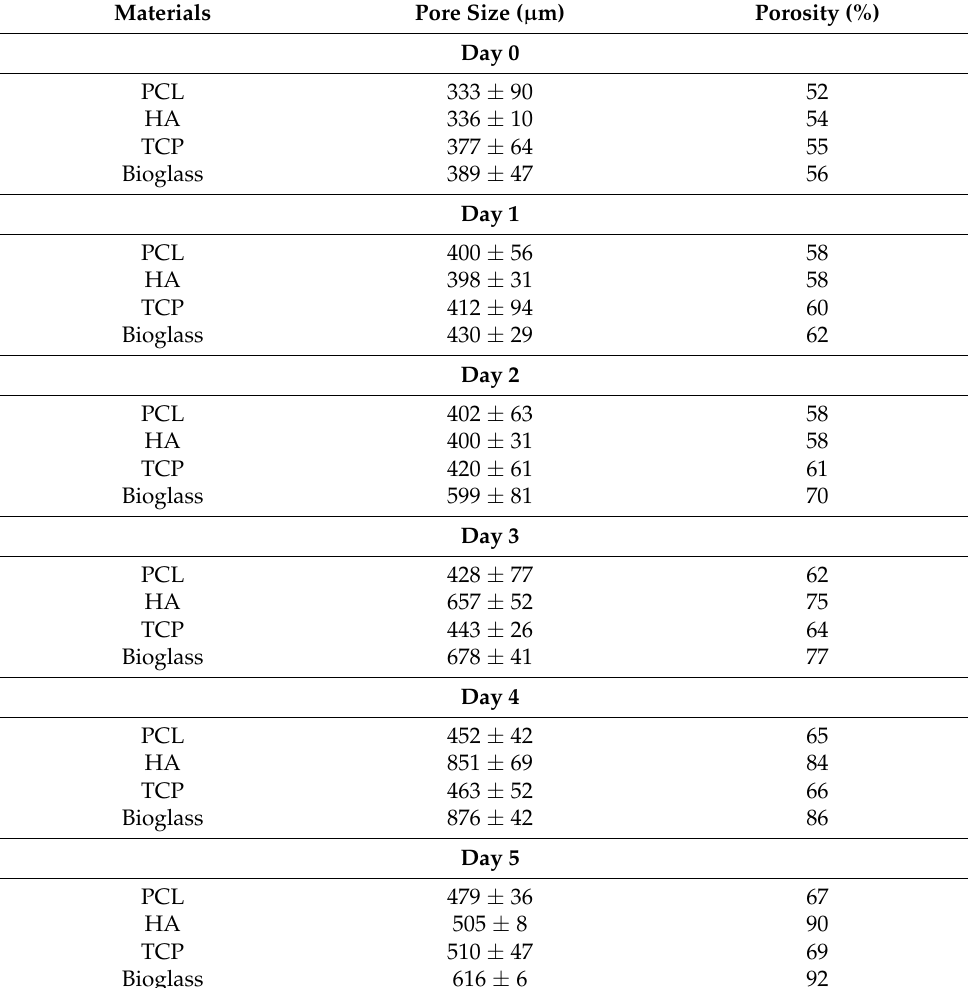
Table 1. Pore size and porosity values of bone brick scaffolds before and after the degradation process.